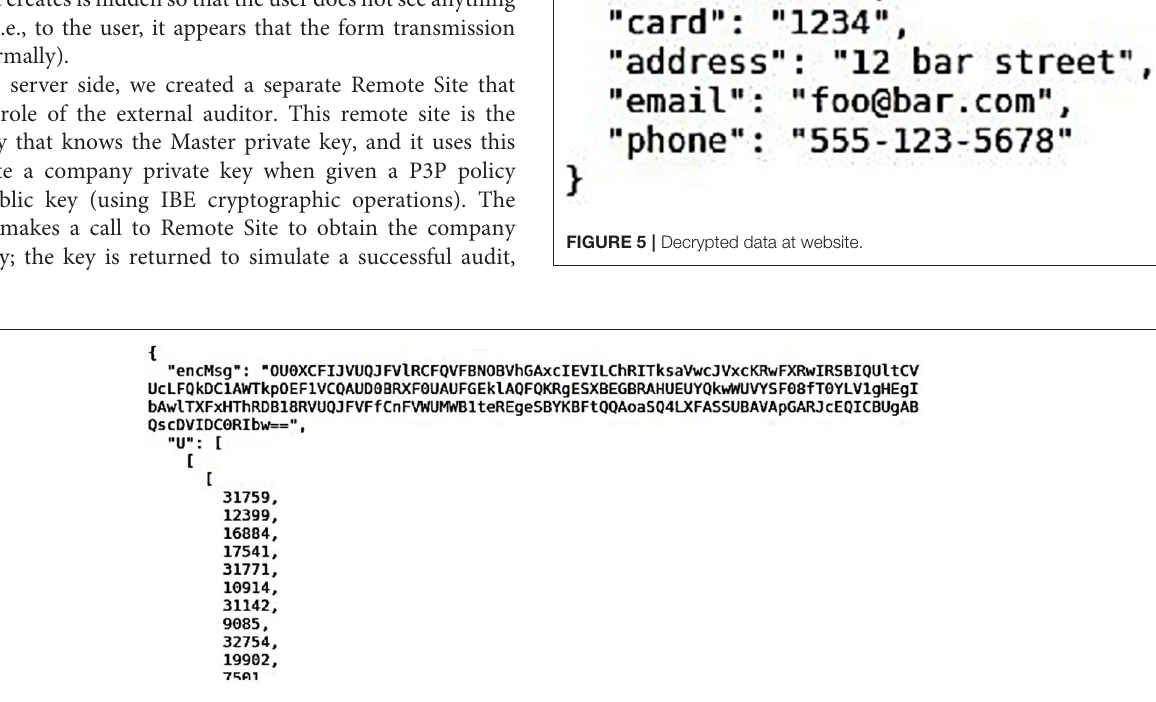
Frontiers in Computer Science |